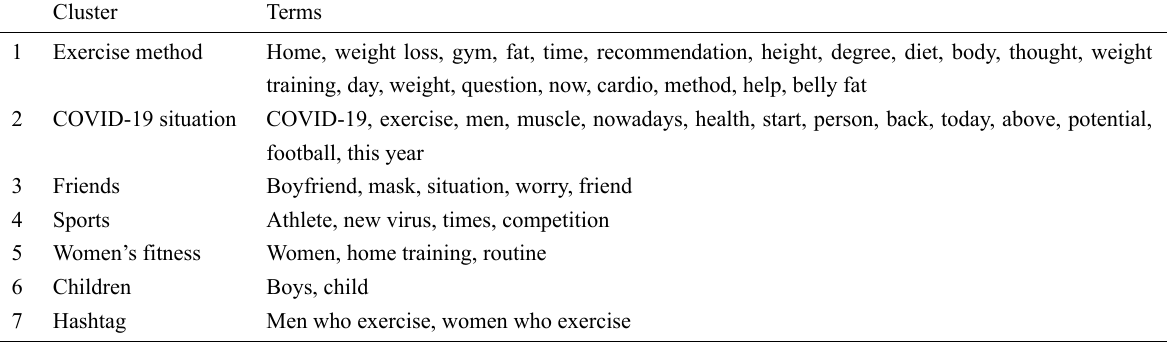
Table 6. Results of the men’s exercise CONCOR analysis.